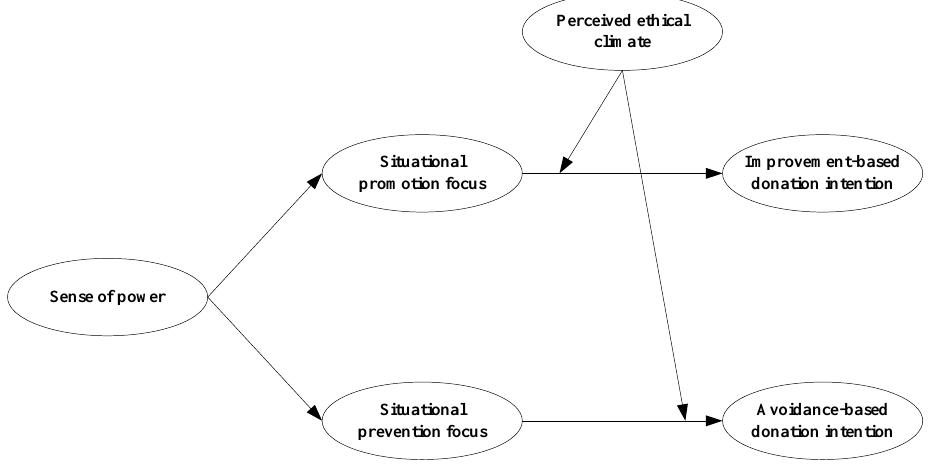
Figure 1. Hypothesized model.